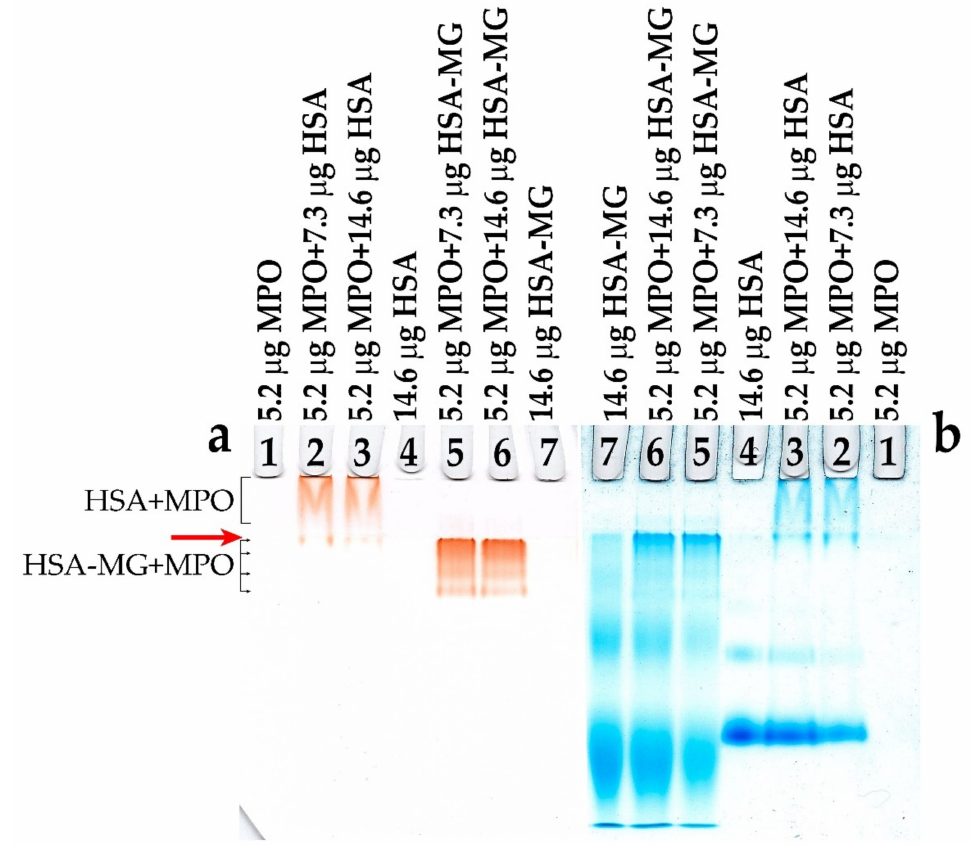
Figure 2. Disc-electrophoresis in polyacrylamide gel without detergents of samples containing MPO, HSA or HSA-MG (1:100, mol/mol). ( a ) Left gel stained by peroxidase activity (0.2 mM o -dianisidine and 100 µ M H 2 O 2 , 100 mM Na-acetate buffer, pH 5.5). ( b ) Right gel stained by protein-specific dye—Coomassie G-250. Red arrow marked joining between stacking and resolving gels, positions of HSA + MPO and HSA-MG+MPO bands marked by black brackets. 1—MPO (36 pmol—5.2 µ g), 2—MPO (36 pmol—5.2 µ g) + HSA (110 pmol—7.3 µ g), 3—MPO (36 pmol—5.2 µ g) + HSA (220 pmol—14.6 µ g), 4—HSA (220 pmol—14.6 µ g), 5—MPO (36 pmol—5.2 µ g) + HSA-MG (110 pmol—7.3 µ g), 6—MPO (36 pmol—5.2 µ g) + HSA-MG (220 pmol—14.6 µ g), 7—HSA-MG (220 pmol—14.6 µ